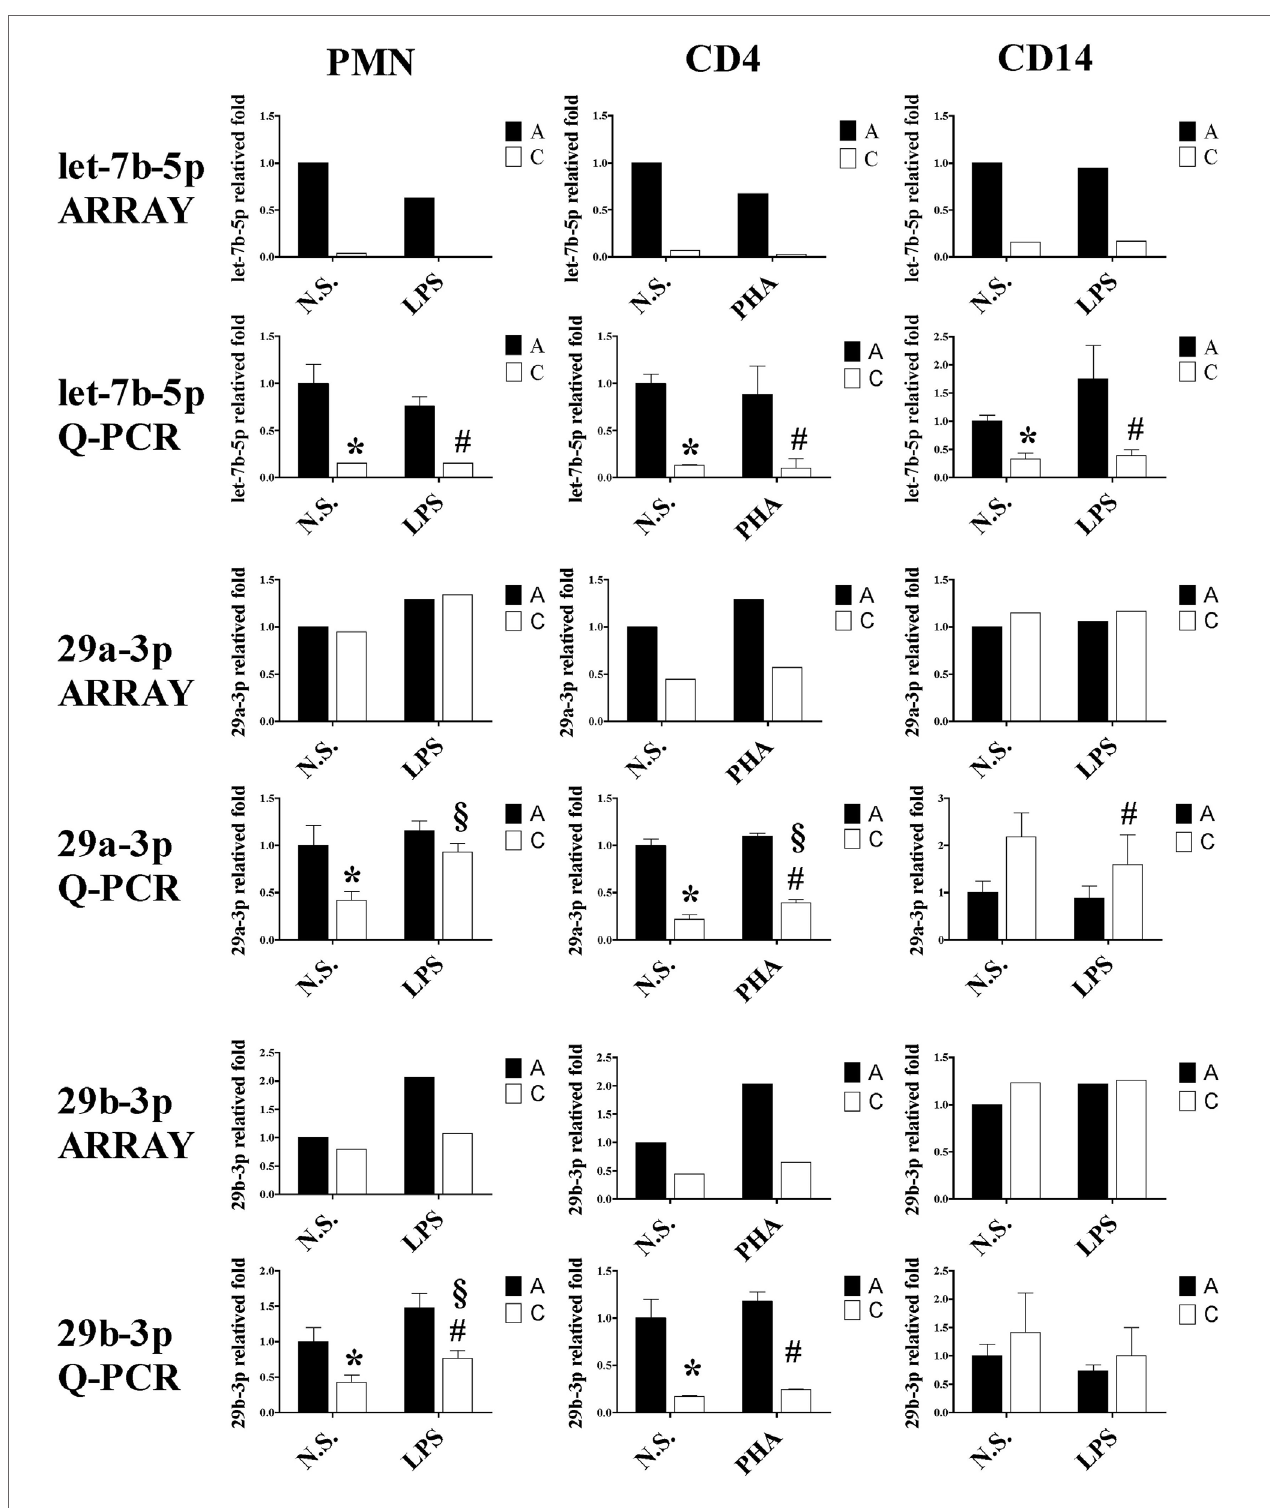
FigUre 11 | Quantitative reverse transcription Pcr (qrT-Pcr) validation of let-7b-5p, 29a-3p, 29b-3p, and mir-130a-3p expression in various leukocyte subsets from cord blood (cB) and adult peripheral blood